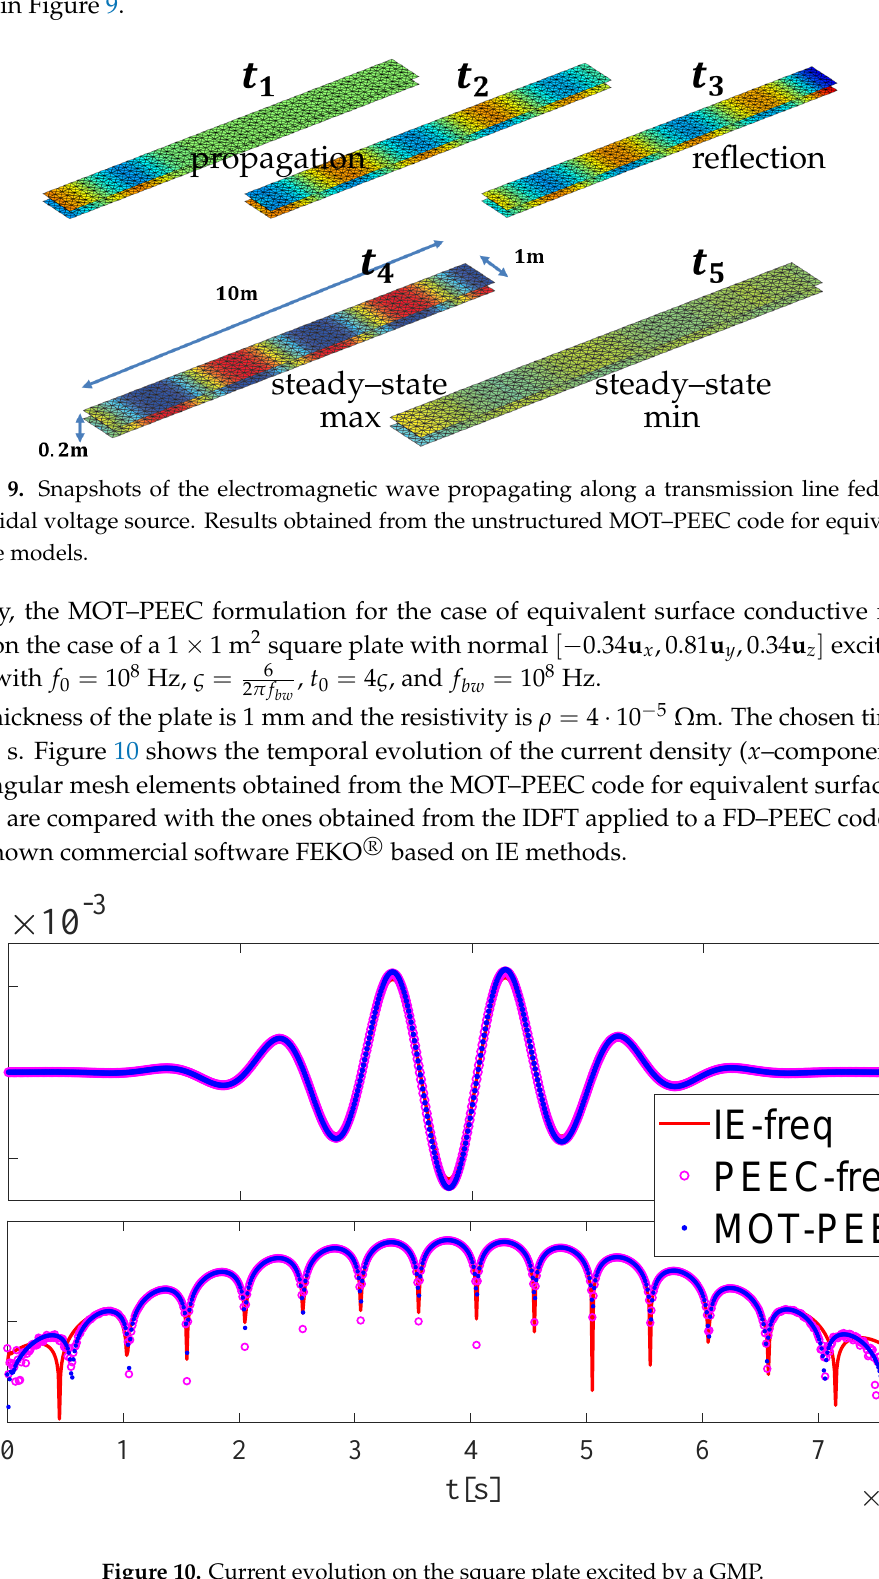
Figure 10. Current evolution on the square plate excited by a